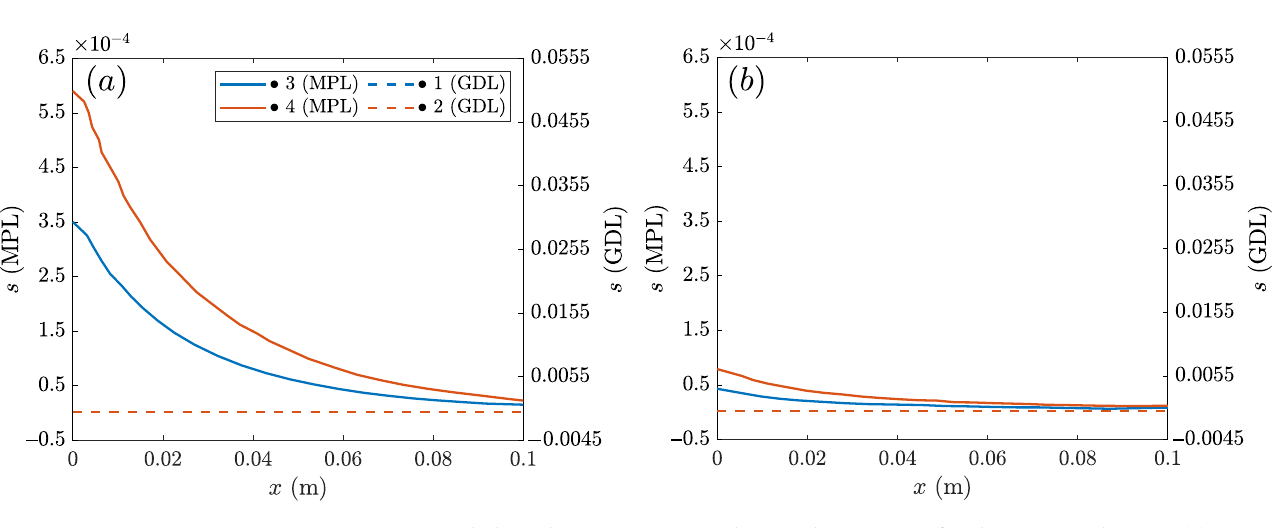
Figure 10. Anode liquid saturation at medium voltage 0.65 V for the cases with MPL: ( a ) AvCarb P-75, ( b ) SIGRACET